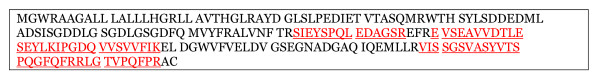
Tryptic peptides of purified rhPln.198 by mass spectrometry. Purified rhPln.198 was subjected to trypsin digest and fragments were analyzed by mass spectrometry. Red underline signifies fragments identified in this analysis of enriched rhPln.198.